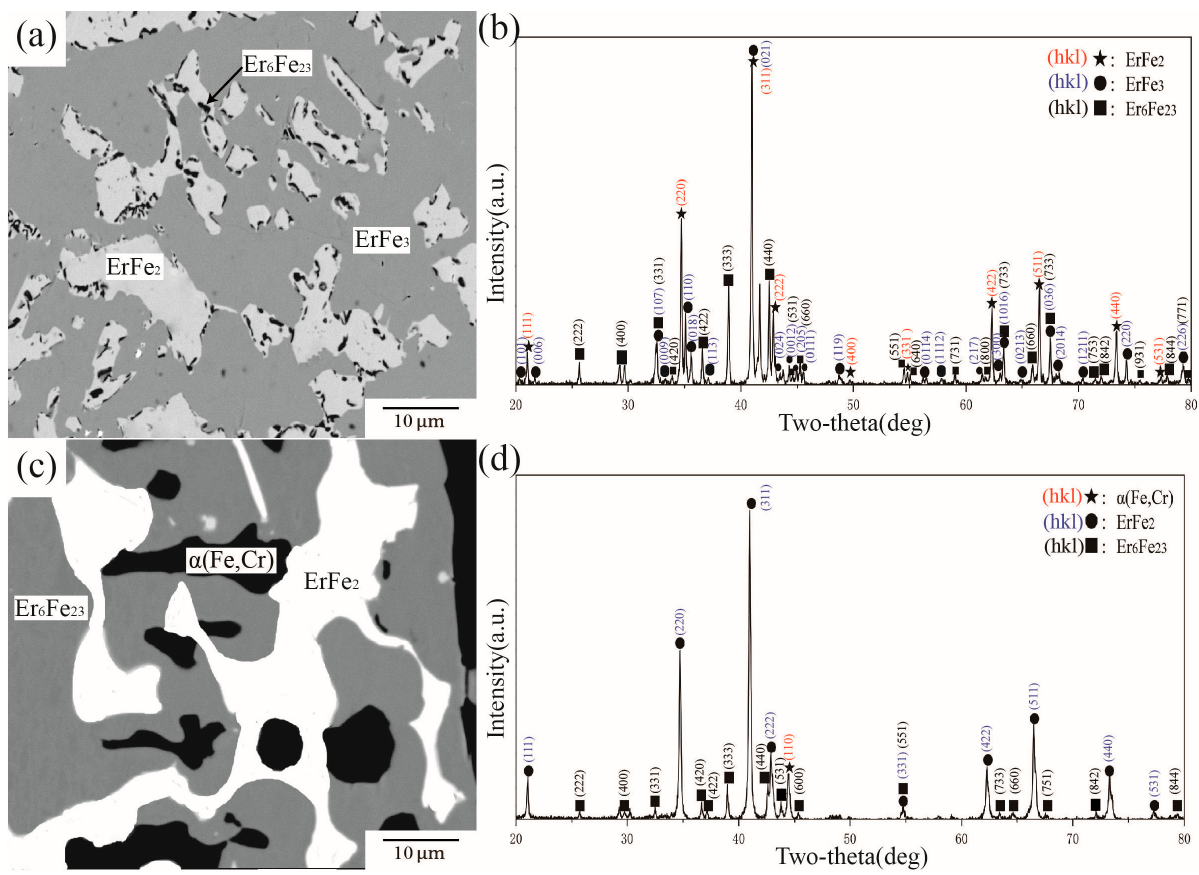
Figure 11. ( a ) BSE image of alloy B1, ( b ) XRD result of alloy B1, ( c ) BSE image of alloy B2, ( d ) XRD result of alloy B2.